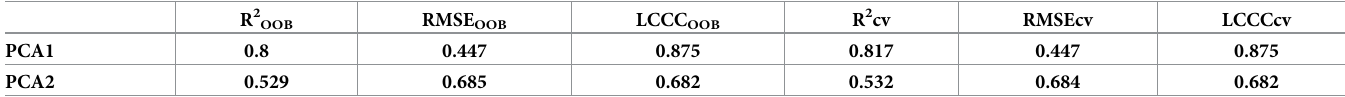
Table 6. Coefficient of determination (R 2 ), root mean square error (RMSE) and Lin’s concordance correlation coefficient (LCCC) of out of bag (OOB) and leave one out cross validation (CV) of random forest for the first two principal components (PCA1 and PCA2). R 2 OOB